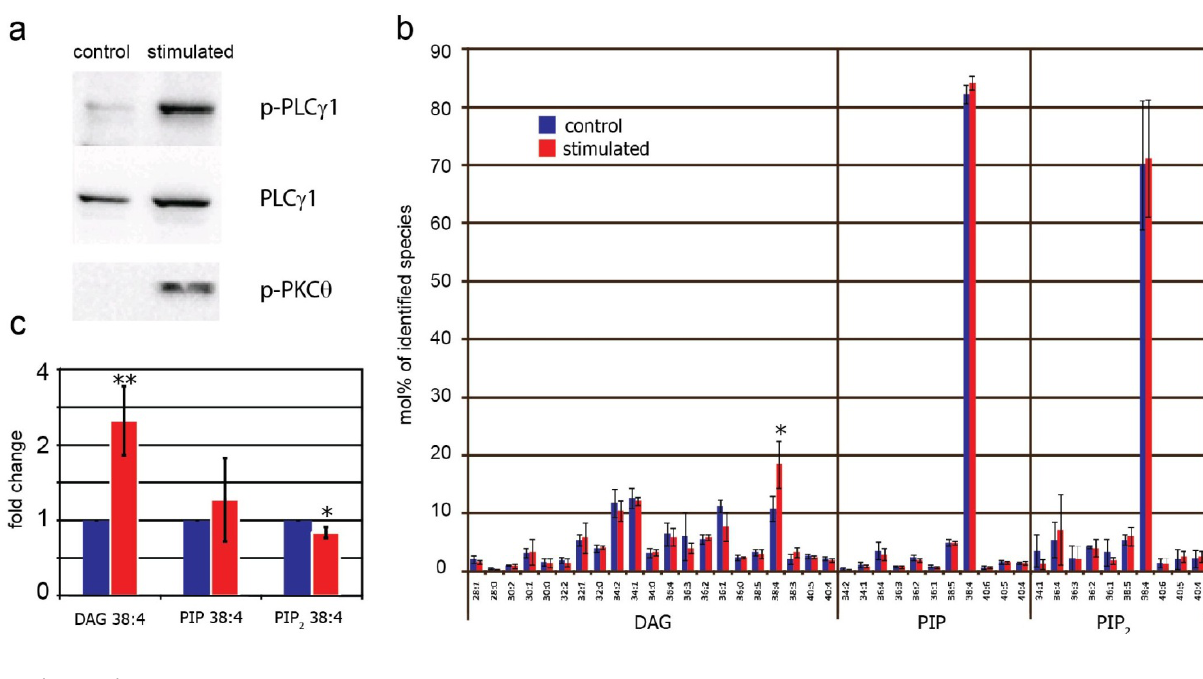
Figure 5. Effect of TCR stimulation on DAG, PIP and PIP levels in T cells. Primary 2 human T cells were stimulated for 5 min followed by a two-step lipid extraction. DAG was analyzed by MPIS in neutral extracts, PIP and PIP were analyzed by scanning for neutral 2 losses of 357 Da and 437 Da in acidic extracts. ( a ) Phosphorylation of PLC γ 1 (p-PLC γ 1) and PKC θ (p-PKC θ ) confirmed the activation of intracellular signaling pathways; ( b ) Effect of TCR stimulation on the relative distribution of DAG, PIP and PIP molecular 2 species identified in T cells. Mol% indicates the distribution of lipid species within a given lipid class; ( c ) Effect of TCR stimulation on the major species DAG 38:4, PIP 38:4 and 38:4. Unstimulated T cells of the same donor were set at 1 and fold-change after PIP 2 stimulation was calculated. Data represent mean values ± SD of three independent analyses with different donors. * p < 0.05, ** p <